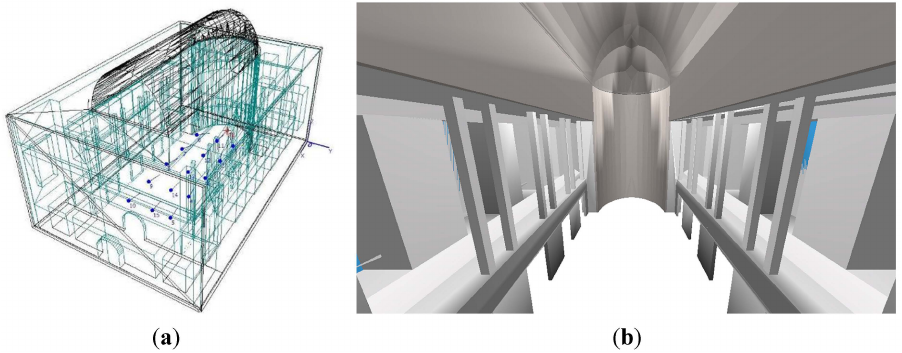
Figure 5. Palatine Chapel: reticulated geometry ( a ) and rendering as given by Odeon ( b